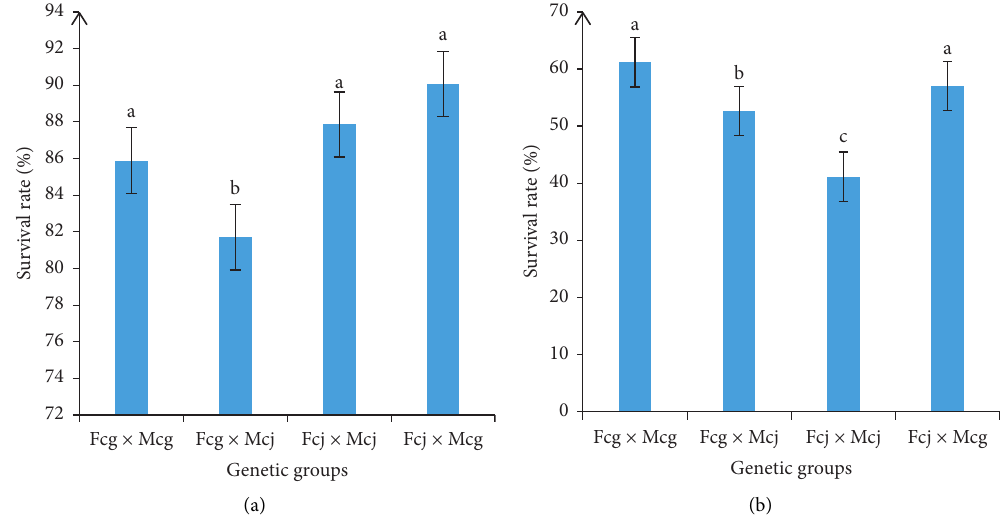
Figure 4: Survival rate in reciprocal hybridizations of Clarias gariepinus × Clarias jaensis under controlled conditions: (a) larval stage (D3) and (b) fry stage (D32). a, b, c: bars with the same letters are not significantly different ( p > 0 . 05). The female was named first.